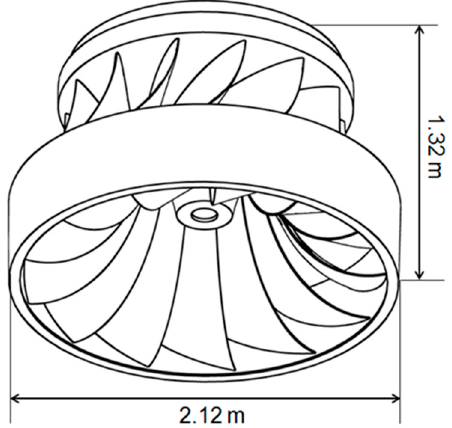
Figure 1. Geometry and the main dimensions of the investigated Francis runner.